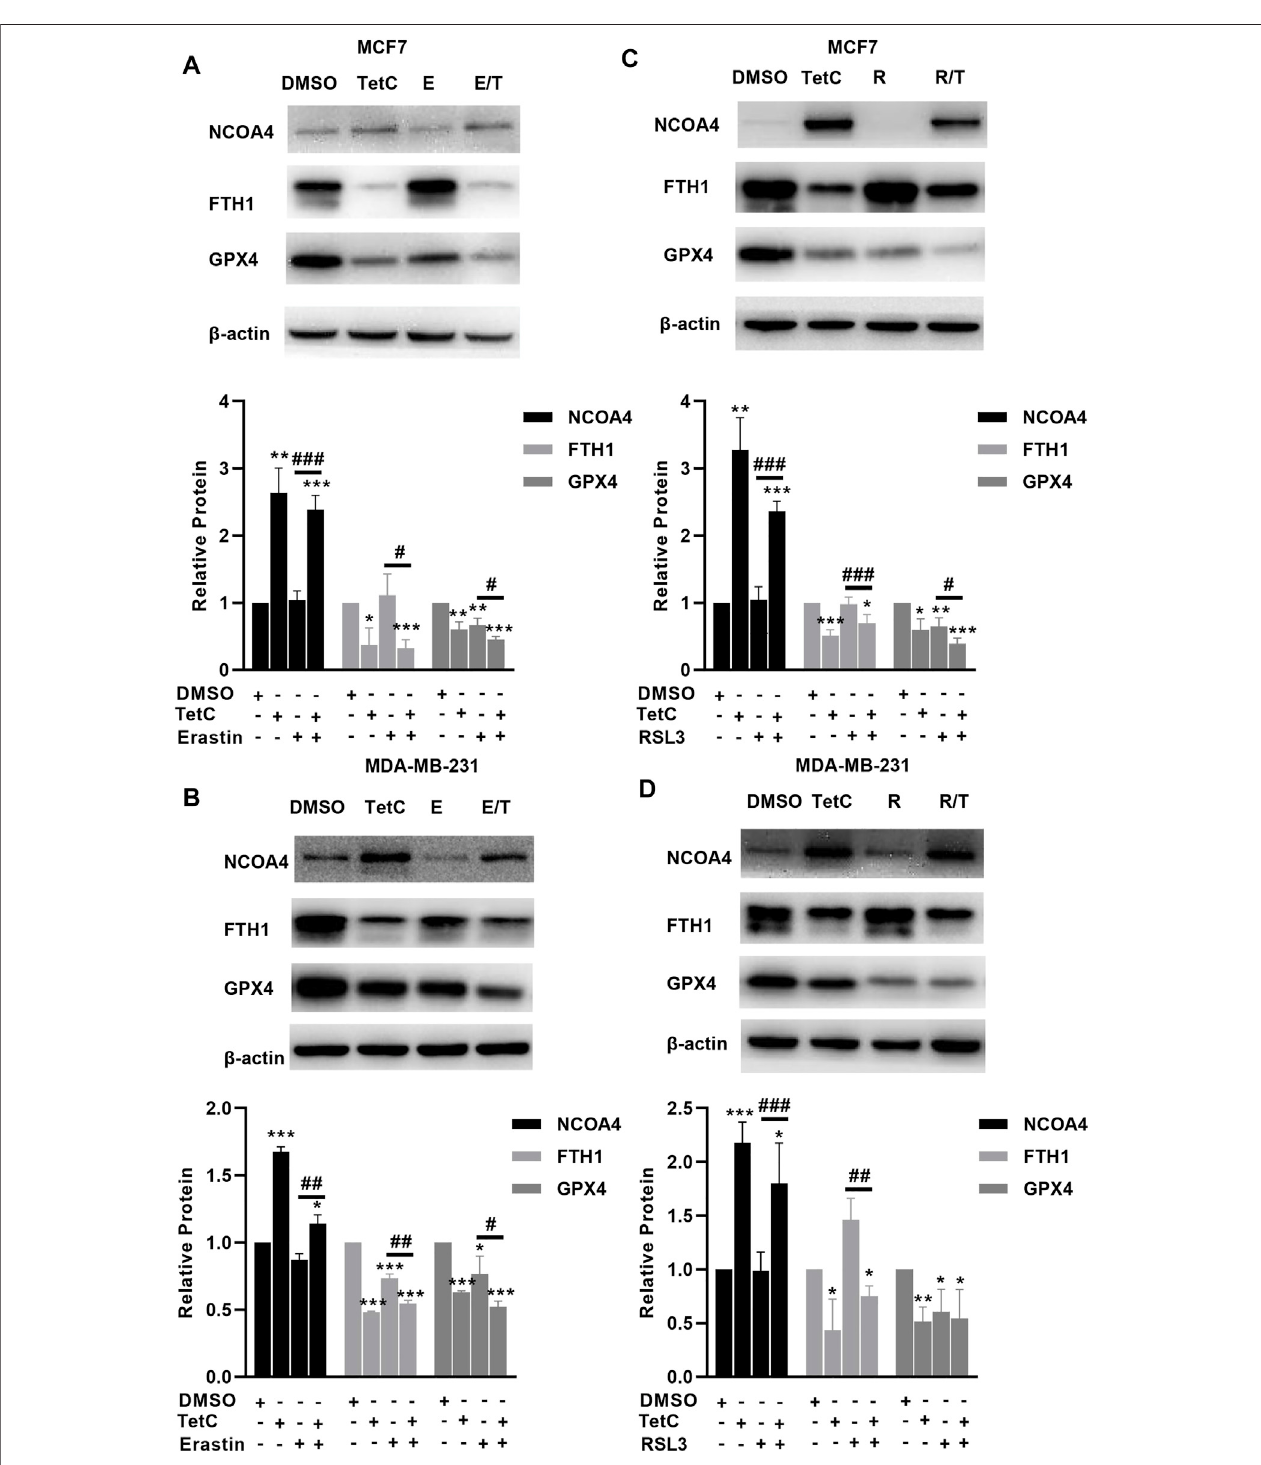
FIGURE5 | TetC activates NCOA4-mediated ferritinophagy and inhibits GPX4 inBC cells. Western blotassay wasperformed toanalyze the effects ofTetC on the genesrelated to ferroptosis comparedwitherastin (A,B) or RLS3 (C,D) alonein MCF7 and MDA-MB-231 cells ( n =3 independent repeats). * p < 0.05; ** p < 0.01; *** p < 0.001 vs. DMSO; # p < 0.05; ## p < 0.01 vs. erastin or RSL3 alone.